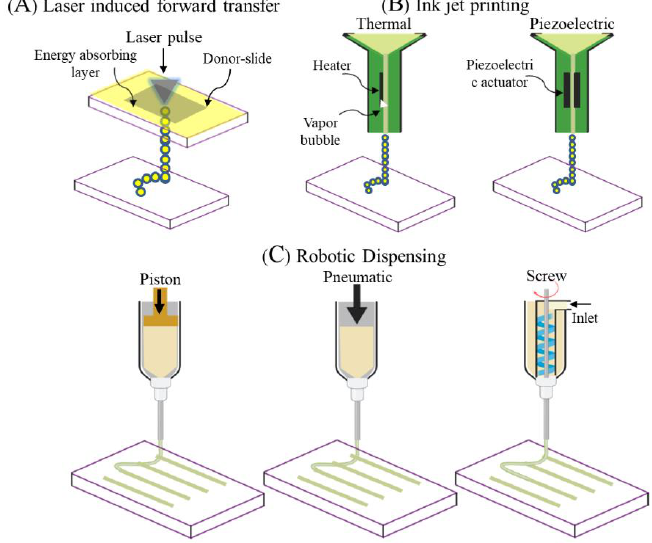
Figure 7. Different types of electrospinning fabrication setups ( A , B ). Forcespinning setup ( C ). Reproduced with permission of [93]. Copyright Wiley-VCH Verlag GmbH & Co. 2013.